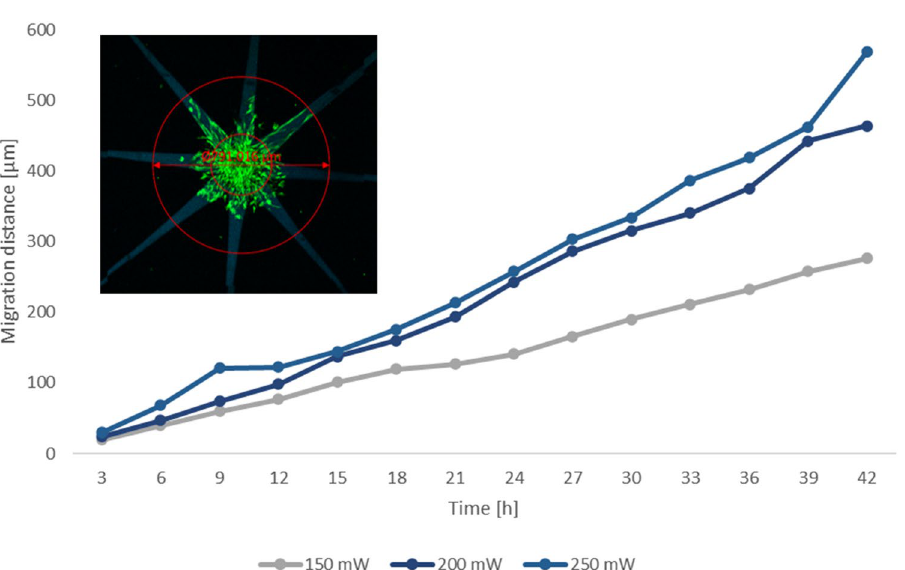
Figure 4. Quantification of hASCs migration: The migration distance of GFP-hASCs into the patterns, photografted at different power settings, is plotted over the time and calculated as a mean value from five samples in total and at least three different data sets per time point. A linear mixed effects model was used to interpret the data, due to the large deviation between samples. The image in the upper left quarter depicts how the migration distance was